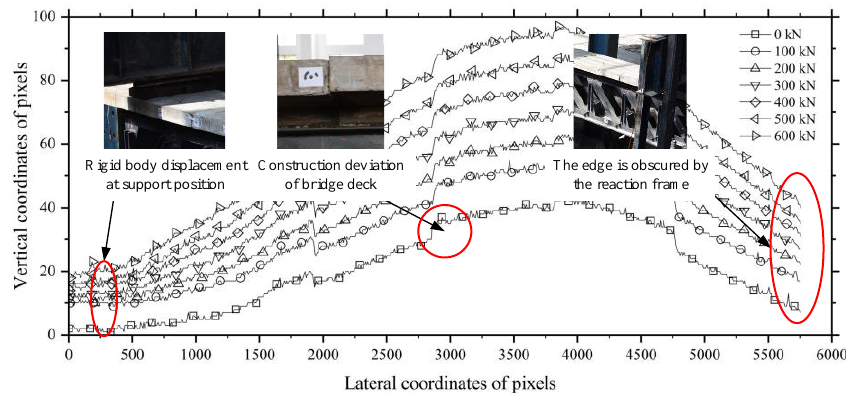
Figure 12. Edge line of lower edge of bridge deck.